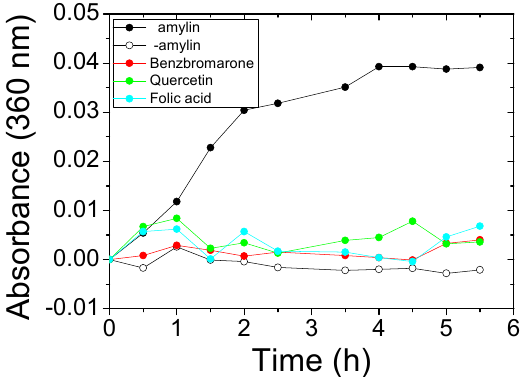
Figure 2. Kinetic aggregation assays of amylin (8–37) in the presence of benzbromarone, quercetin, and folic acid, followed by solution turbidity. Turbidity was measured as absorbance at 360 nm. Black dots: positive aggregation control (only amylin); white dots: negative aggregation control (no amylin); Red, green, and cyan dots: aggregation of amylin with the addition of benzbromarone, quercetin, and folic acid, respectively.